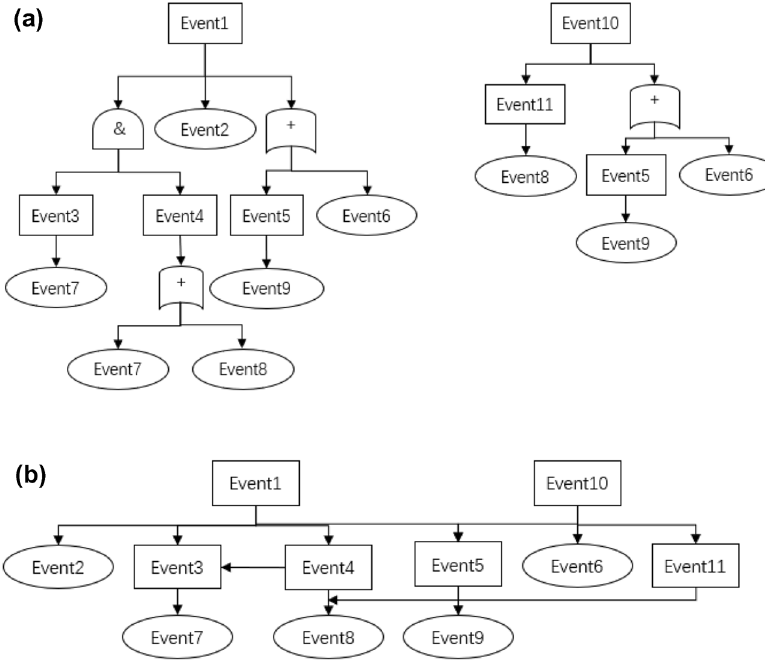
Fig. 7 a Fault tree logic dia- gram before simplification; b fault tree logic diagram after simplification